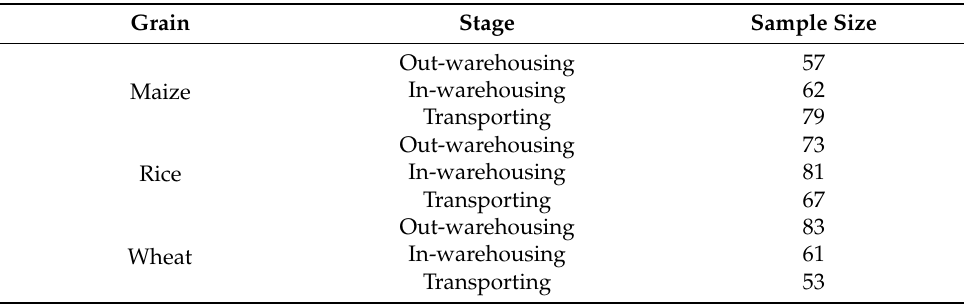
Table 1. Sample information.